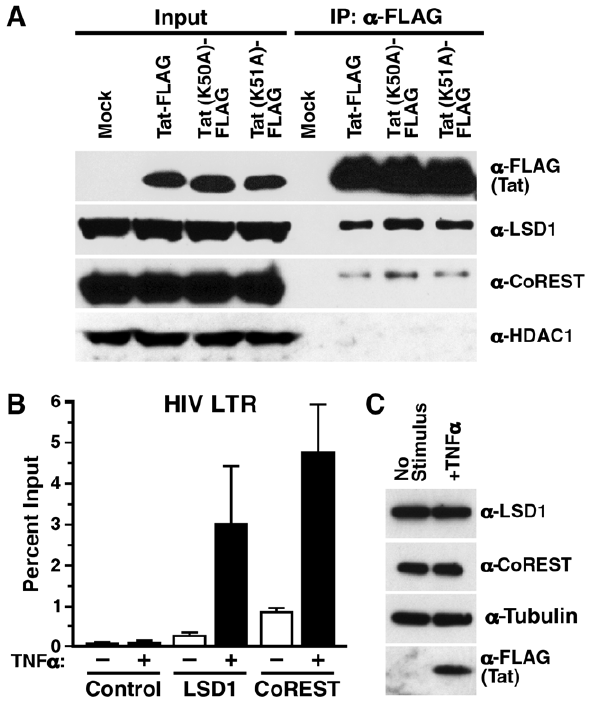
Figure 5. Invivo recruitment of LSD1 and CoREST to the HIV LTR. (A) Co-immunoprecipitation of endogenous LSD1 and CoREST with Tat/FLAG and the Tat K51A mutant in transiently transfected 293T cells. (B) Chromatin immunoprecipitation analysis of LSD1, CoREST and HDAC1 in J-Lat A2 cells. A2 cells were stimulated with TNF a over night and chromatin immunoprecipitation was performed using a -LSD1, a - CoREST, a -HDAC1 or no antibodies followed by real-time RT-PCR with primers specific for the HIV LTR region. (C) Whole cell lysates isolated from A2 cells stimulated with TNF a over night were analyzed by western blotting using a -LSD1, a -tubulin or a -FLAG